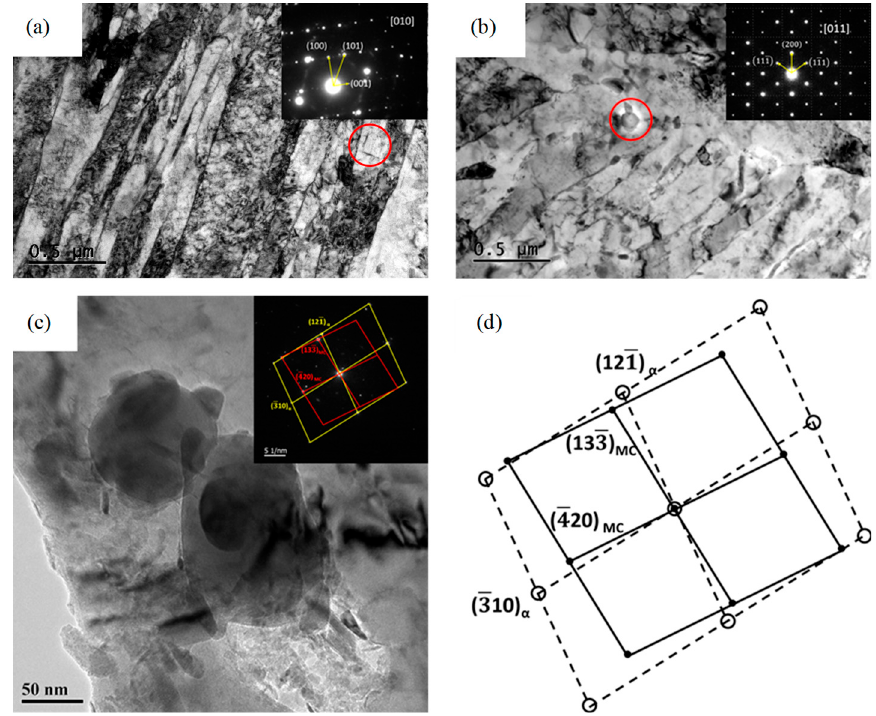
Figure 8. TEM images showing different kinds of precipitates of 25Cr3Mo2NiWVNb steel after tempering at 640 °C. ( a ) M 2 C; ( b ) M 6 C; ( c ) MC; ( d ) the corresponding diffraction pattern of MC.